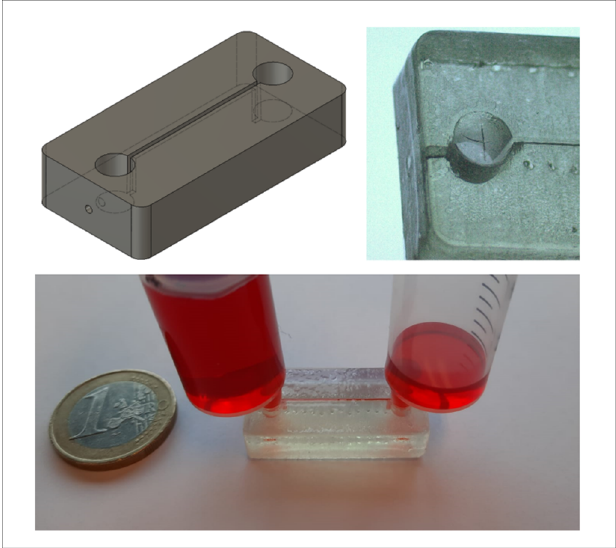
Figure 10. Absorbance measurement at 617 nm for the cuvette-shaped microfluidic structure, flushed consecutively with 0.3, 0.6 and 1 mg/mL 2-MXP solution.